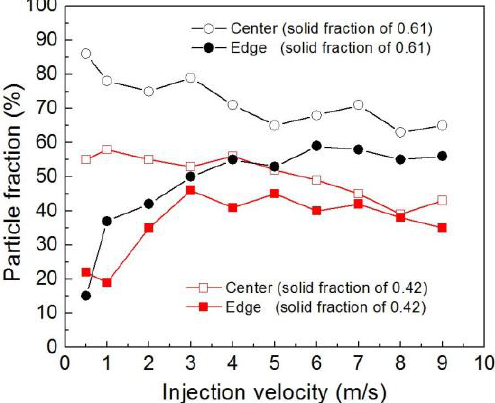
Figure 11. Variation of the primary α -Mg fraction in the center and edge of the sample with different solid fractions as the effect of injection velocity.